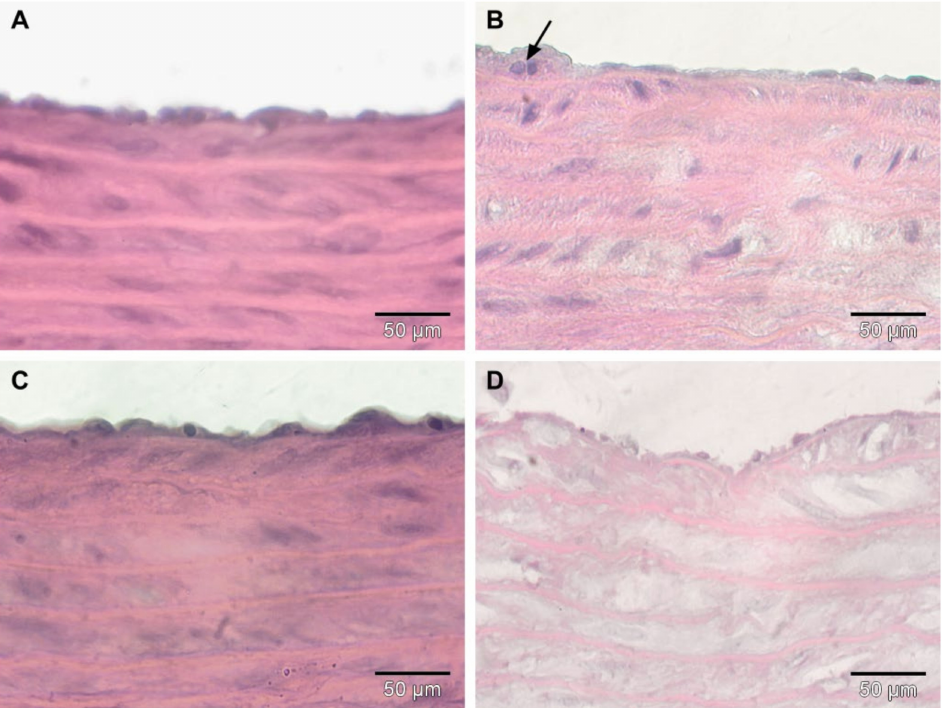
Figure 6. Haematoxylin-eosin staining of descending aorta of rats with 9 months of HFD, the last month with oral gavage treatment (0.9% saline solution for Control and HFD groups; Cornus mas L. extract for HFD + CM group; gold nanoparticles functionalized with bioactive compounds from Cornus mas L. extract for HFD + AuNPsCM group) showed normal morphology in Control group ( A ), macrophages (arrow) in subendothelial connective tissue layer in HFD group ( B ), thinner elastic laminae in HFD + CM group ( C ) and discontinued intima, rarefied elastic layers and several large intercellular spaces in HFD + AuNPsCM group ( D